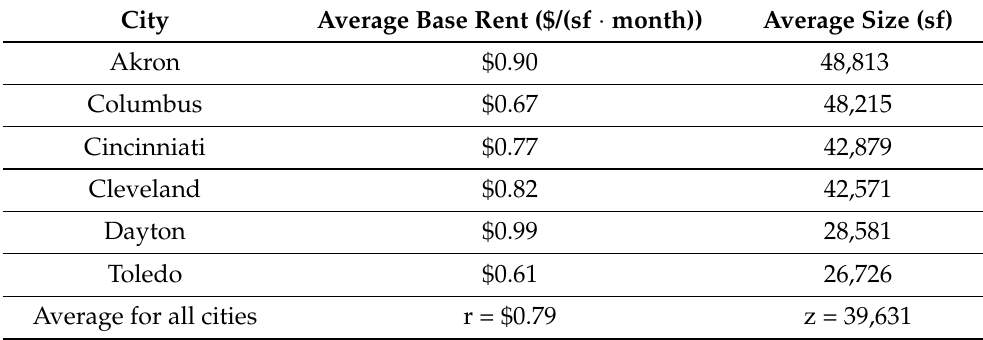
Table 2. Average rent and size of warehouses in